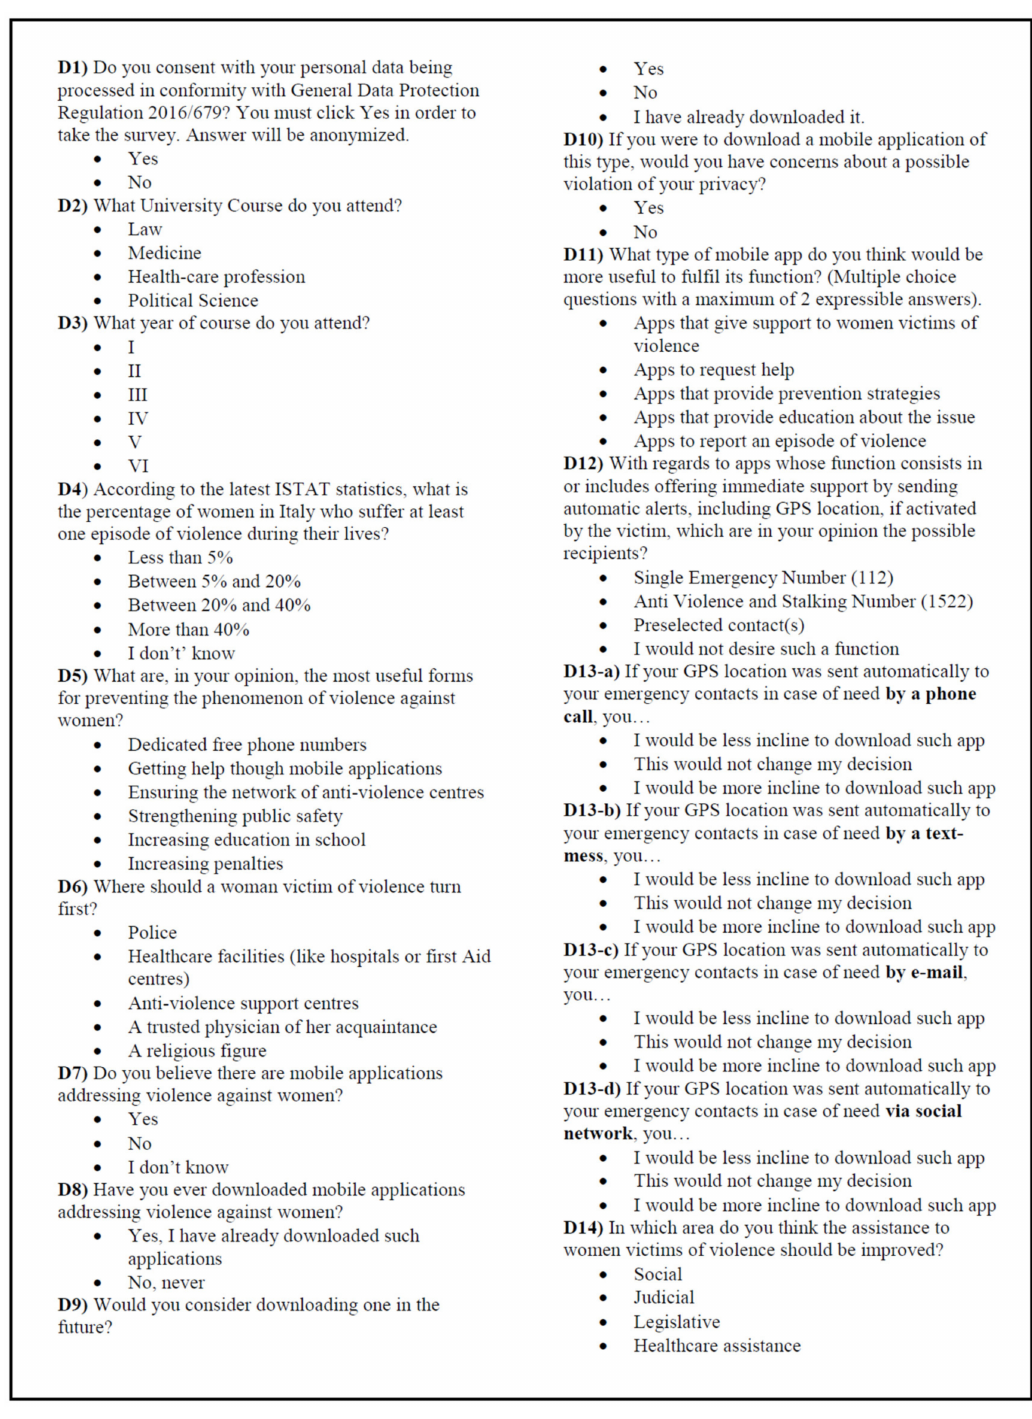
Figure 1. English translation of the administered